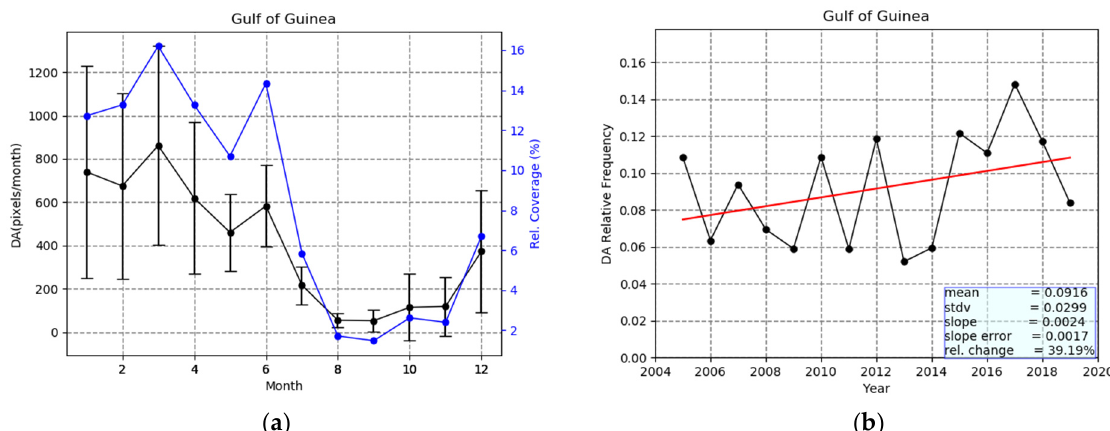
Figure 11. ( a ) Intra-annual variability of the 2005–2019 averages of the total absolute number of grid cells (1° × 1°) where dust aerosols (DA) were detected over Gulf of Guinea by the satellite algorithm (left axis) and the percent coverage of the region by dusty grid cells (right axis). The error bars represent the year-by-year variability by means of computed 2005–2019 standard deviations. ( b ) Inter-annual variability and linear trend of the relative frequency of dust aerosols (DA) over Gulf of Guinea.